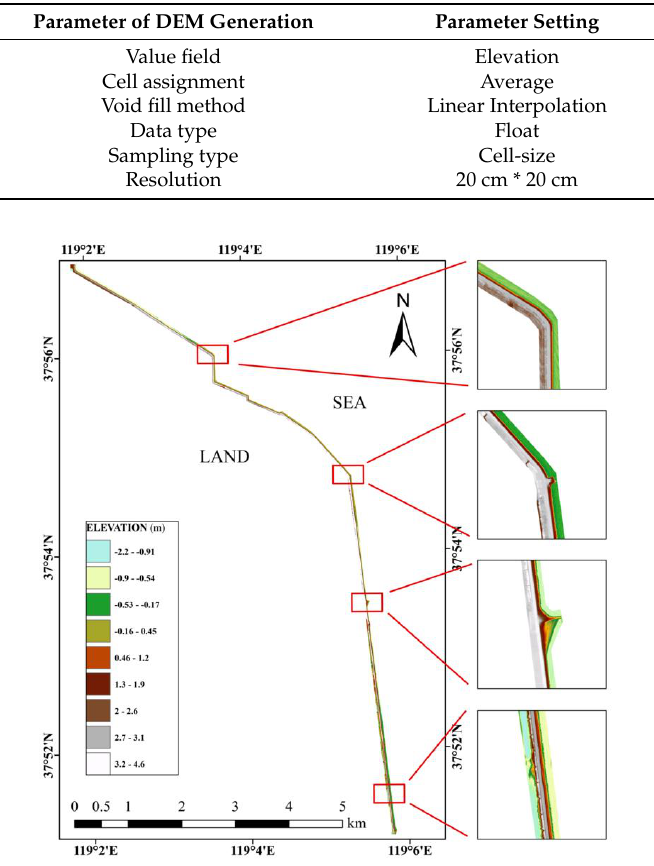
Figure 8. Strip DEM of Gudong Dam and its details.